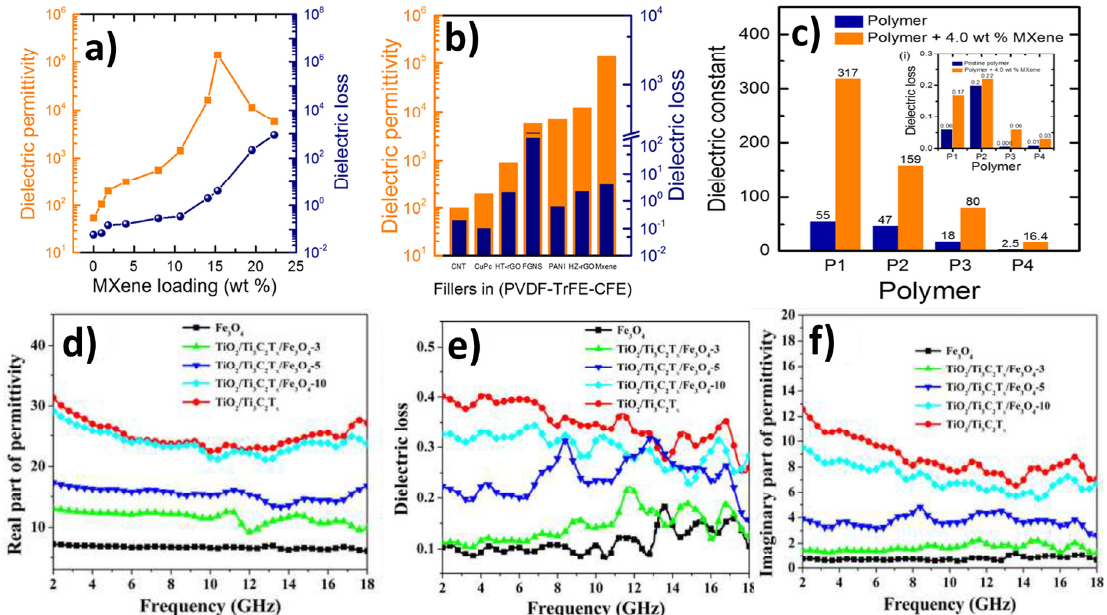
Figure 6. ( a ) Dielectric permittivity and loss of the MXene/Polymer composites on MXene content wt % measured at RT and 1 kHz, ( b ) Bar charts comparing the dielectric permittivity and communicating loss described in the research report employing polymer as a matrix with diverse conductive fillers, ( c ) Dielectric constant of various polymers with and without MXene. Inset ( i ): Dielectric loss of diverse polymers inserted with MXene stacking; P1: P(VDF-TrFE-CFE); P2: P(VDF-TrFE-CTFE); P3: P(VDF-TrFE); P4: PVP, ( d ) Frequency dependence of ( a ) real part of permittivity and ( f ) imaginary parts of permeability for the Fe 3 O 4 , TiO 2 /MXene, and TiO 2 /MXene/Fe 3 O 4 composites over 10–18 GHz and ( e ) Dielectric dissipation factors of the Fe 3 O 4 , TiO 2 /MXene, and TiO 2 /MXene/Fe 3 O 4 composites in the frequency range of 2–18 GHz. Copyright: Ref. 41 and 110.